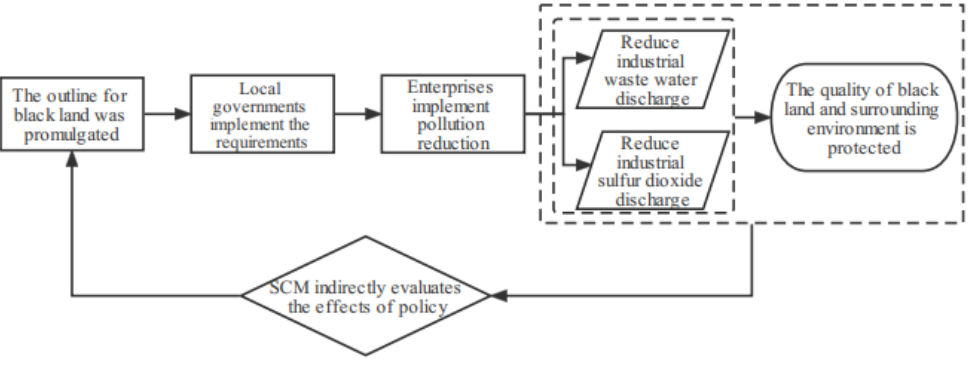
Figure 1. Evaluation of the effect of the BLPP.